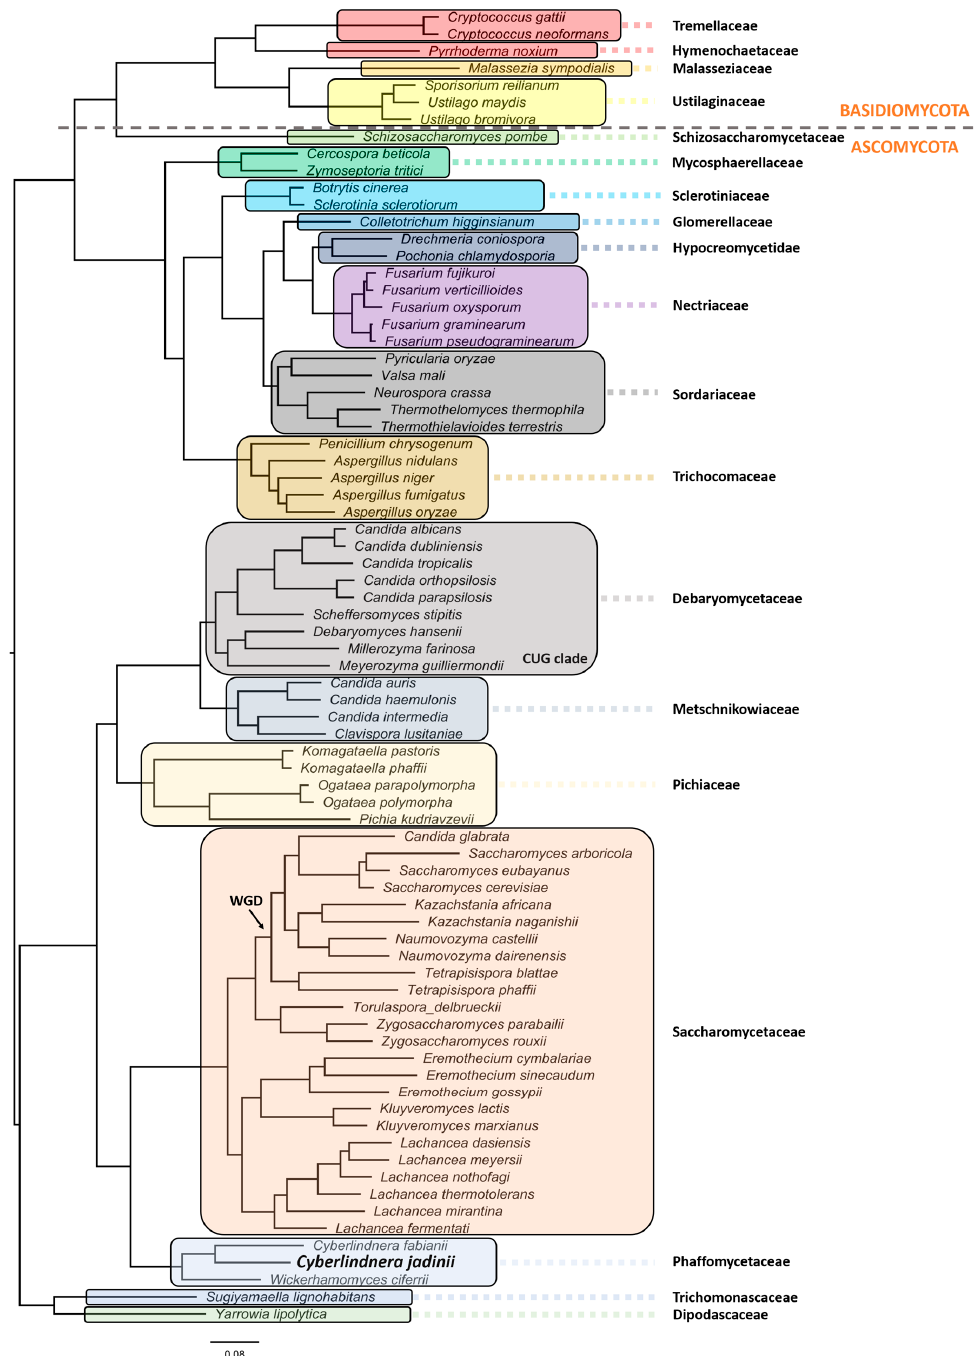
Figure 1. Evolutionary relationship of Cyberlindnera jadinii , a member of the Phaffomycetaceae clade. The phylogenetic reconstruction was obtained using the following parameters: maximum likelihood in IQ-TREE (http://www.iqtree.org), the model of amino acid evolution JTT (Jones-Taylor-Thornton), and four gamma-distributed rates. Homologues were detected for 1567 proteins across the proteome of 77 selected fungal species from NCBI. The 1567 set of proteins were aligned and then concatenated in order to use in the phylogenetic analysis. These proteins offer a clear high-resolution evolutionary view of the different species, as they are essential proteins beyond the specific biology of the different yeasts. Bootstrapping provided values of 100% for all the nodes. Yeast and fungi families are highlighted with different colors and shades. The phylogenetic relationships reflect evolutionary ancestries, independently of adaptations and overall gene contents within the various species. All families with more than one representative species in the analyses formed monophyletic